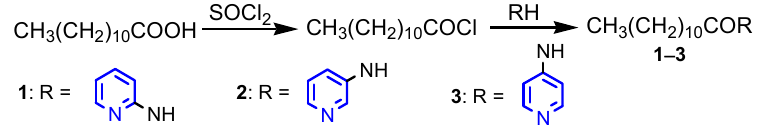
Scheme 1. Synthesis of dodecanoic acid pyridines 1 − 3 [14].